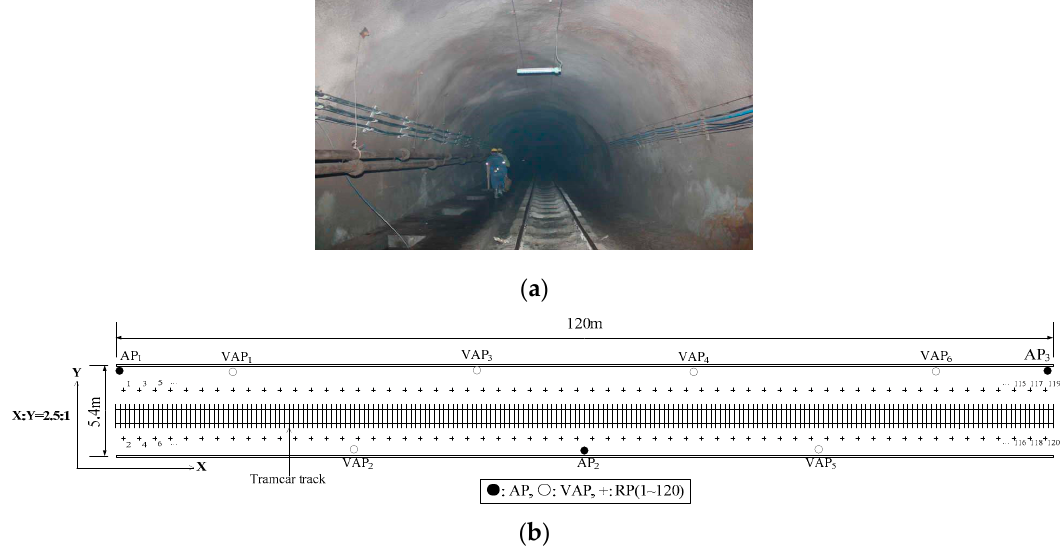
Figure 15. Diagram of experimental environment II: ( a ) Picture of the underground tunnel; ( b ) Plan of the underground tunnel.